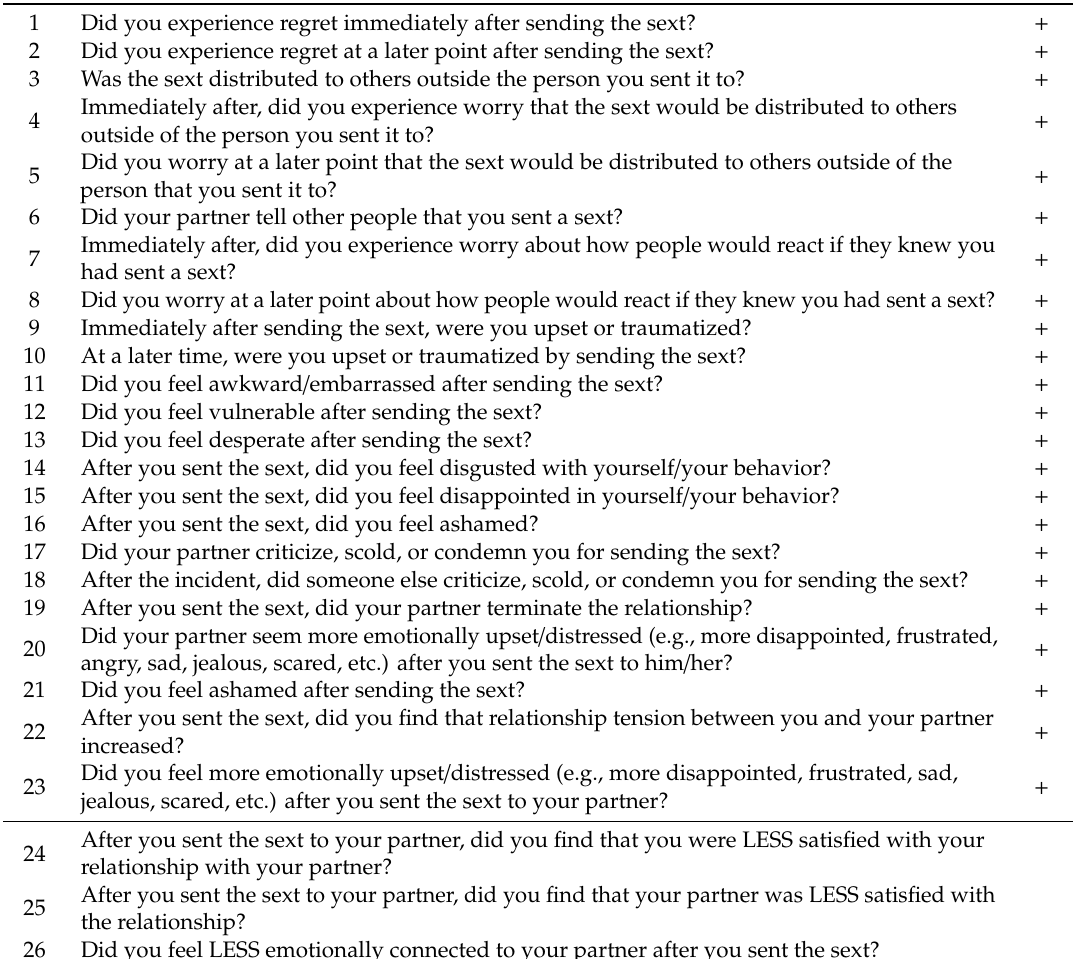
Table A2. Punishment